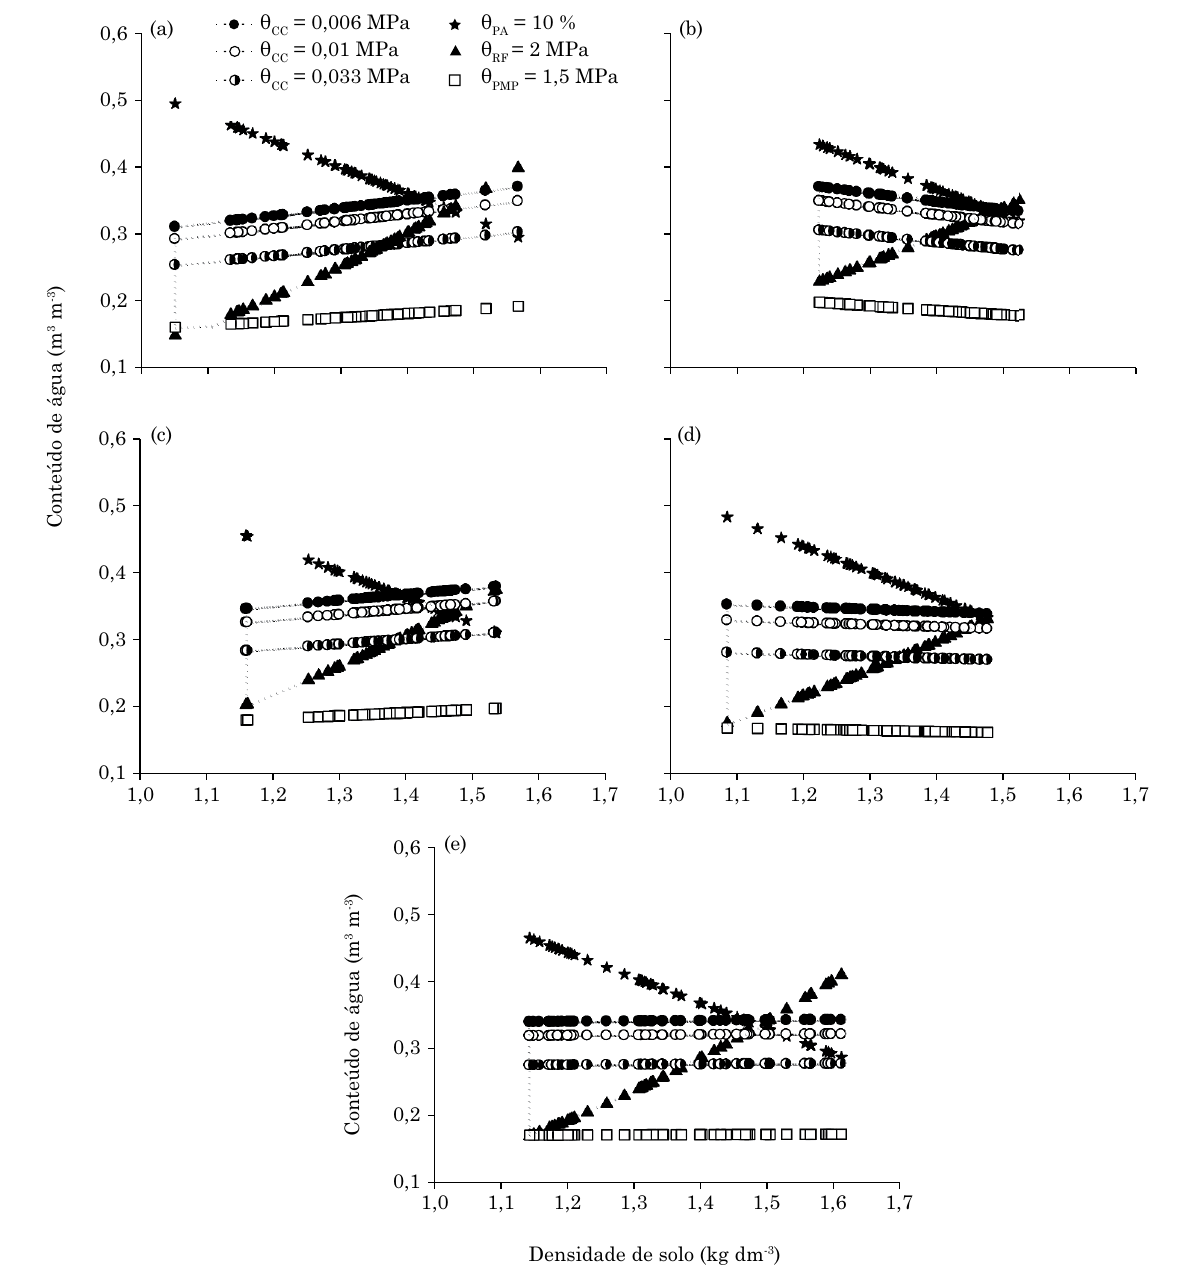
Figura 1. Intervalo hídrico ótimo (IHO) de um solo construído em área de mineração de carvão considerando como limite superior três condições de umidade de solo no potencial de água na capacidade de campo (θ CC = 0,006; 0,01 e 0,033 MPa). (a) Solo construído cultivado com Hemarthria altíssima (T1); (b) Solo construído cultivado com Paspalum notatum (T2); (c) Solo construído cultivado com Cynodon dactilon (T3); (d) Solo construído cultivado com Urochloa brizantha (T4); e (e) Solo construído sem a implantação de plantas de cobertura